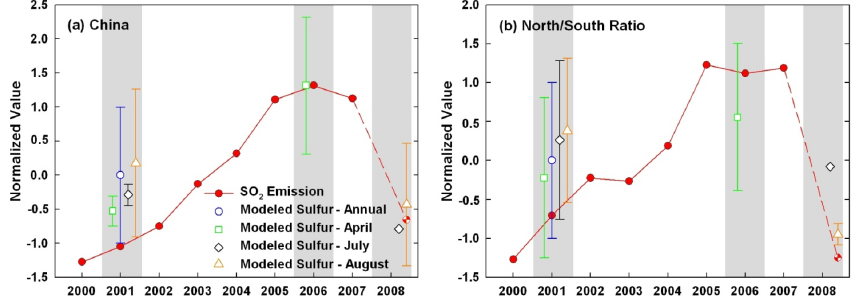
) concentrations averaged over 4